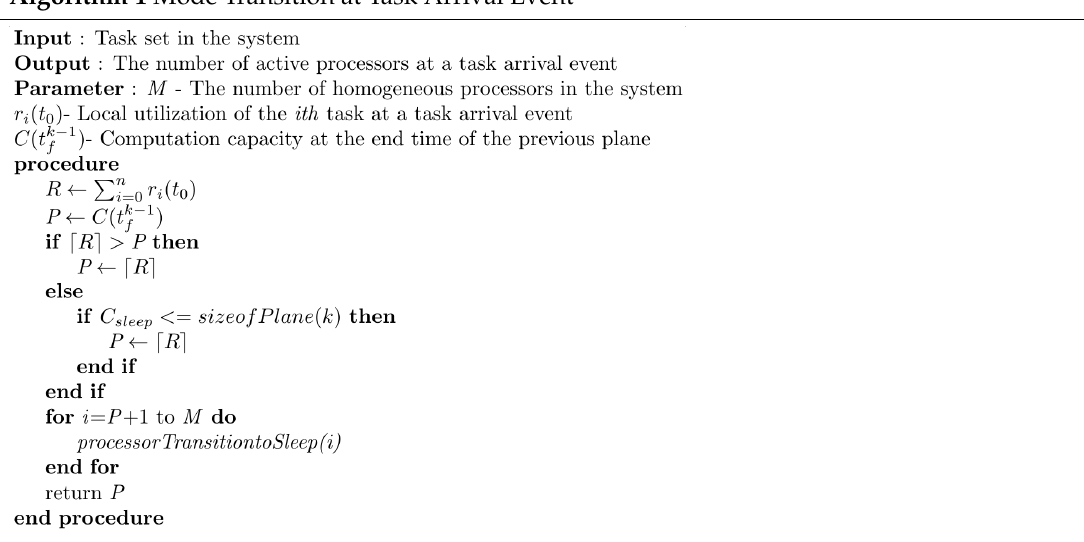
Algorithm 1 Mode Transition at Task Arrival Event